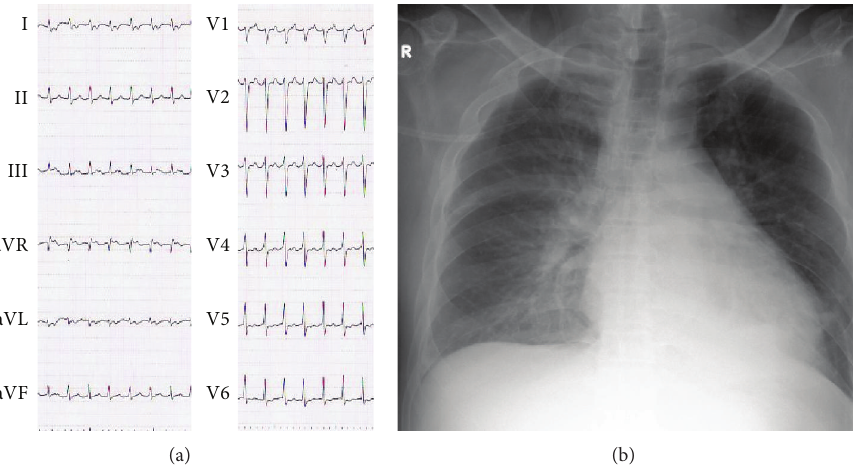
Figure 1: Twelve-lead electrocardiogram (ECG) (a) and chest X-ray on admission (b). ECG shows narrow QRS tachycardia suggesting paroxysmal supraventricular tachycardia. Chest radiography showed bilateral pulmonary congestion and